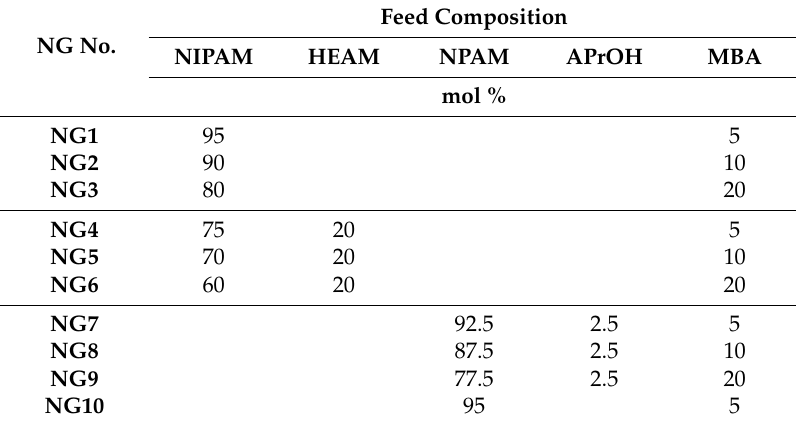
Table 1. Chemical compositions for nanogels NG1–NG10. Feed NG No.